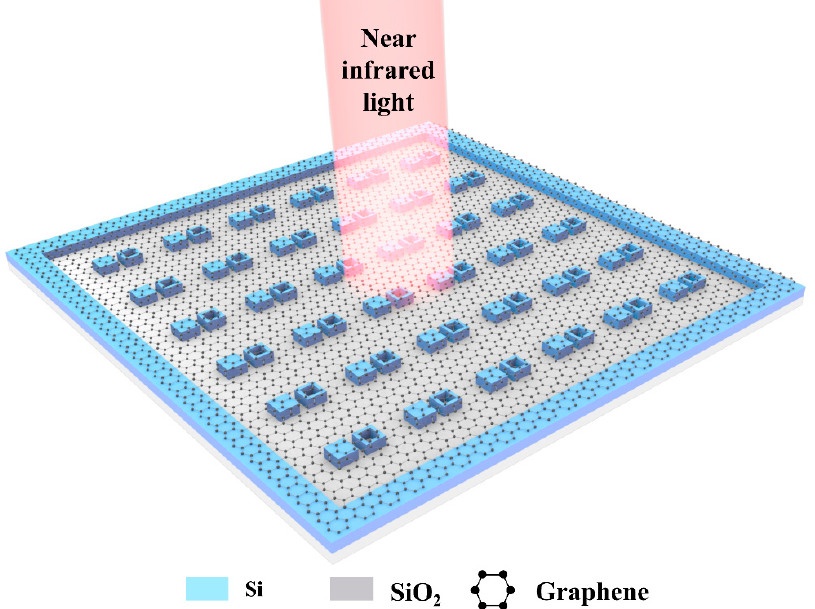
Figure 1. The schematic illustration of the proposed metamaterial, which consists of a solid nanocube (SNC), a hollow nanocube (HNC), and a monolayer graphene and quartz substrate. For graphene, both intra-band and inter-band transitions contribute to its complex surface conductivity, which can be calculated by the theory of random phase approximation in the local limit and is described as following [30]: